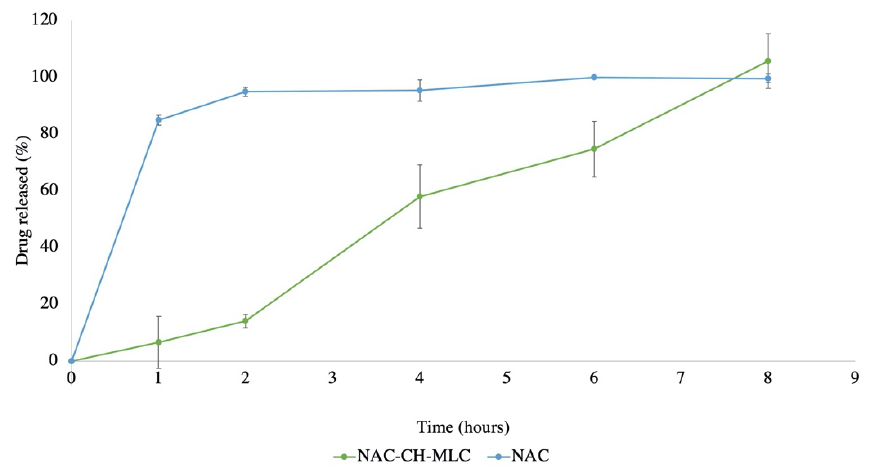
Figure 9. Drug-release % through artificial mucus over time of NAC-CH-MLC and pure NAC.